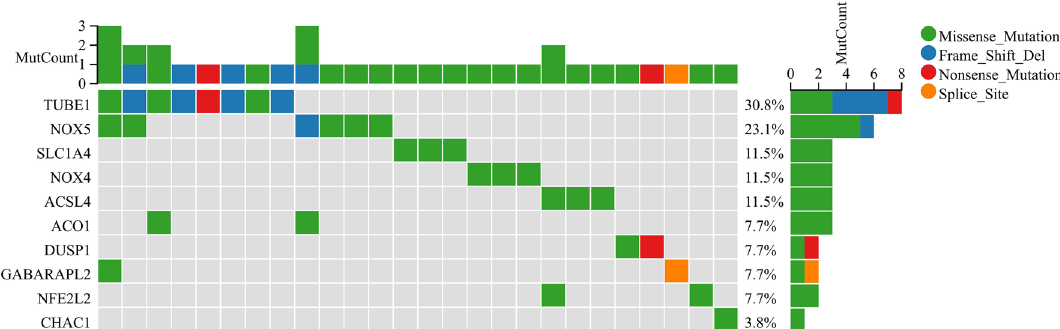
Figure 6. Mutations of FRPGs in the training cohort. The green represents Missense Mutation, blue represents Frame Shift Del, red represents Nonsense Mutation, and orange represents Splice